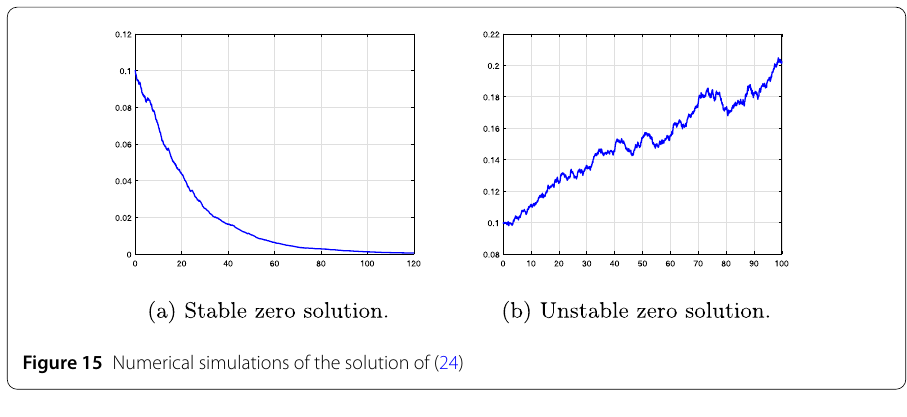
Figure 16 Practical uniform exponential solution of